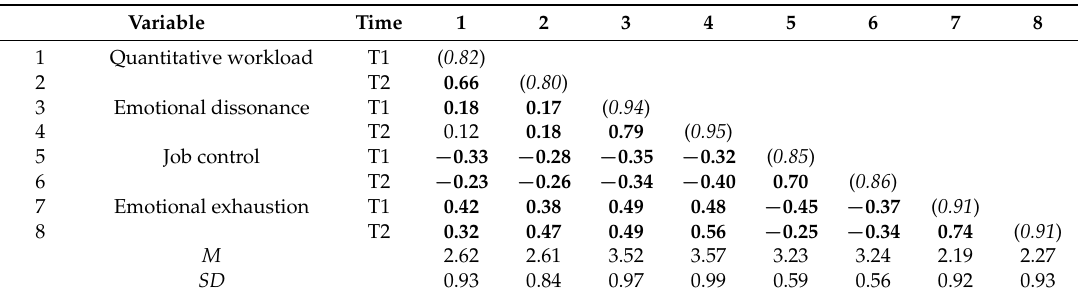
Table 1. Means, standard deviations, internal consistencies ( Cronbach’s Alpha ) and bivariate correlations of study variables. Variable Time